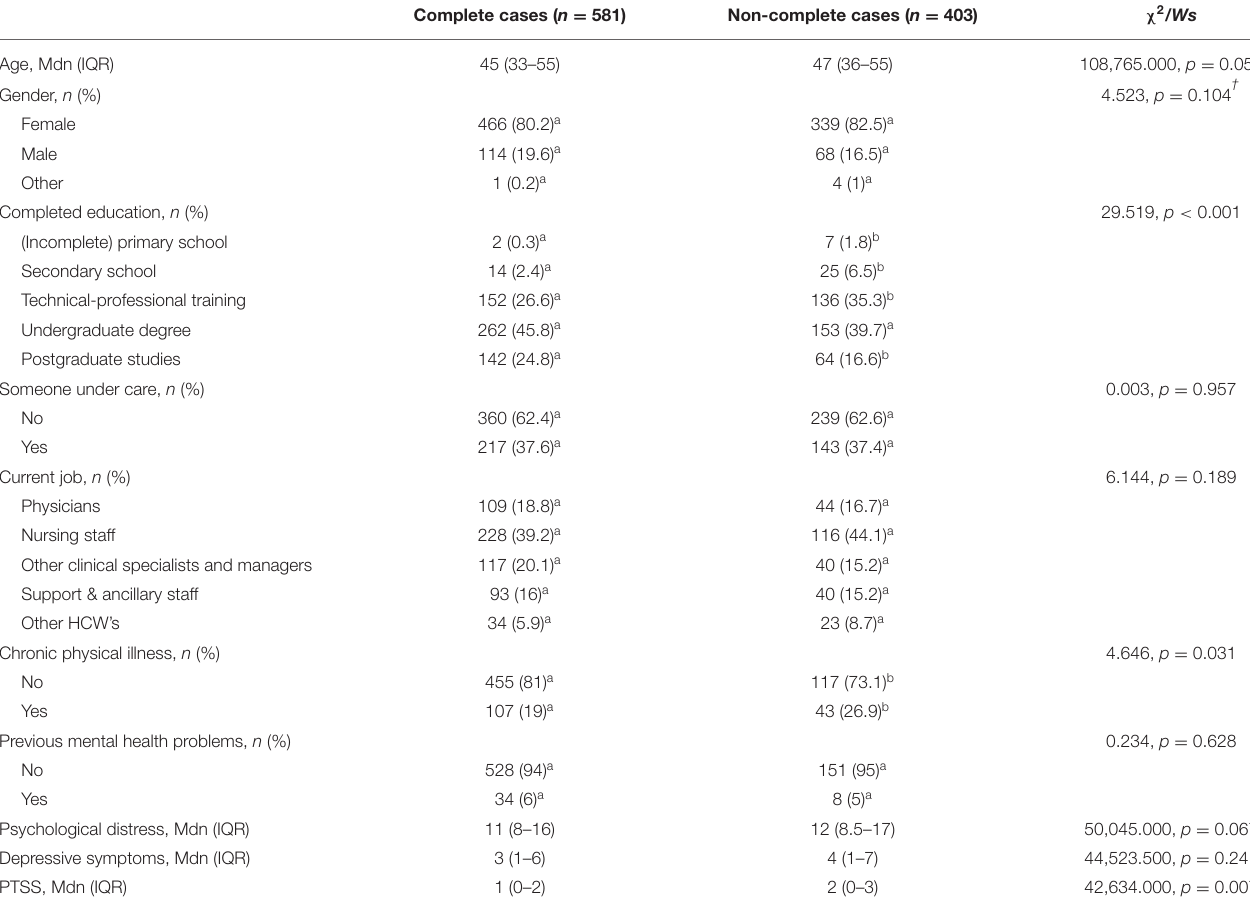
TABLE 1 | Descriptive statistics for confounding and outcome variables for complete cases and non-complete